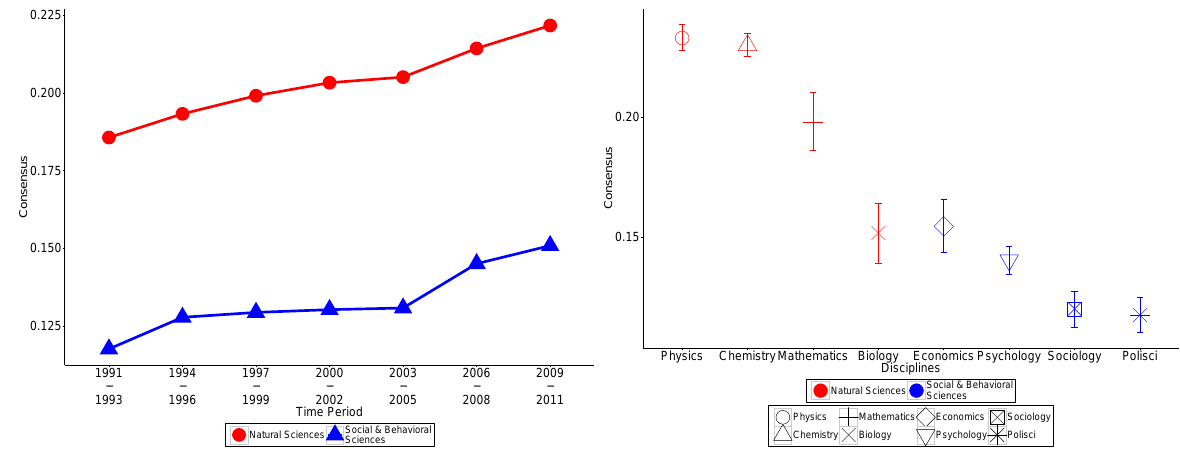
Figure 3: Consensus values over time by science/social science group and